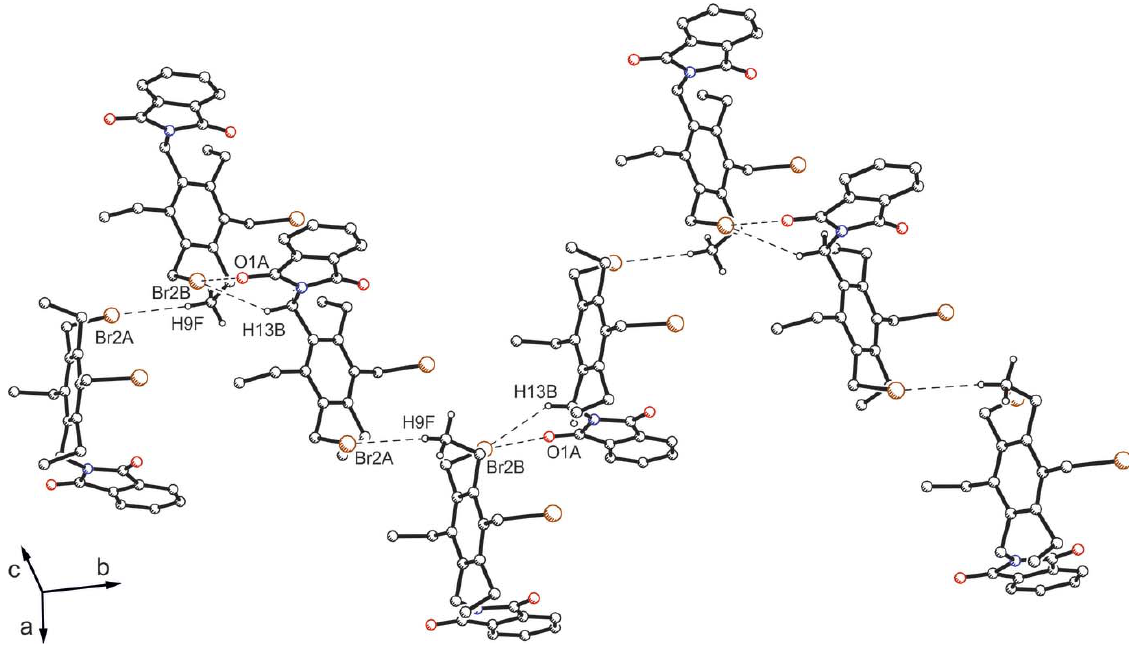
Figure 3 Packing excerpt of 1 showing C—Br (cid:2)(cid:2)(cid:2) O C and C—H (cid:2)(cid:2)(cid:2) Br halogen and hydrogen bonds, respectively (dashed lines). Hydrogen atoms of subunits that are excluded from intermolecular interactions are omitted for clarity.